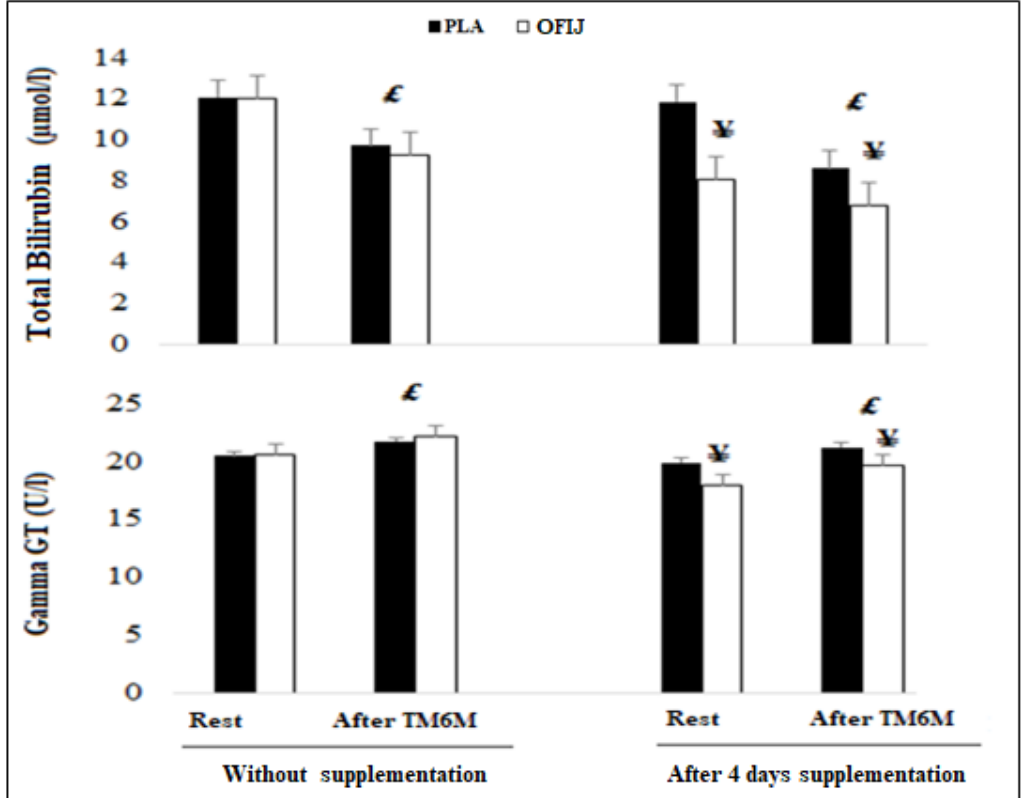
Figure 7. Hepatic parameters (mean ± SD; n = 20) recorded before and after the 6MWT during without and with supplementation of PLA and OFIJ. £: significant difference compared to before the 6MWT ( p < 0.05). ¥: significant difference compared to without supplementation ( p < 0.05).